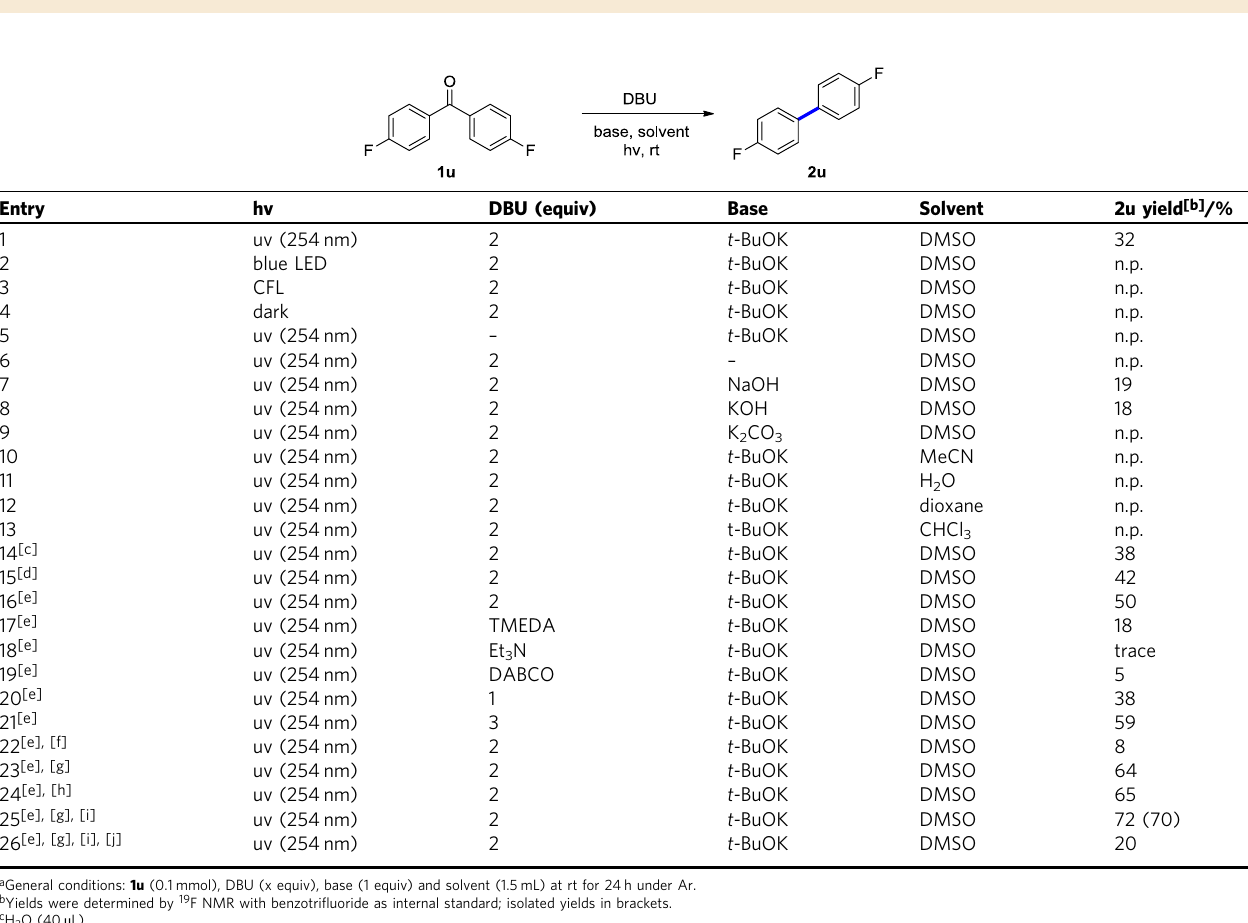
Table 1 Optimization of the reaction conditions a